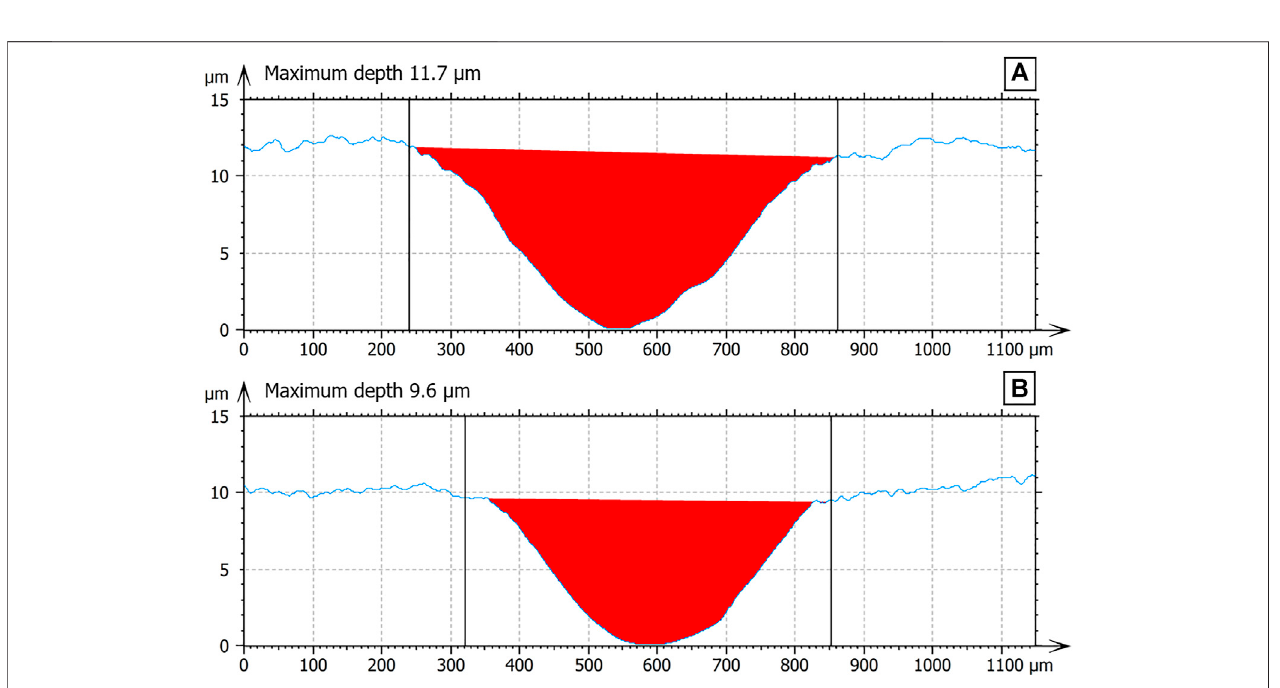
FIGURE 13 | Average cross-sectional pro fi le of the wear track: (A) Ni.G and (B) Mo.G.